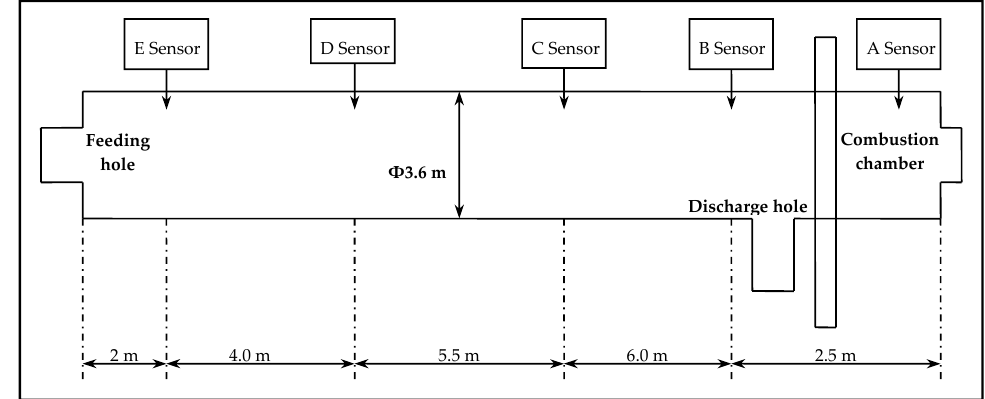
Figure 1. Schematic diagram of rotary kiln in the local factory.